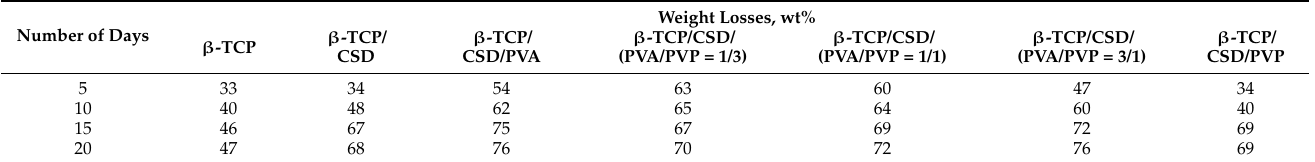
Figure 6. Relative viscosity measurement of the 5% solution of the PVA/PVP mixture. Table 2. Weight losses of the composites and the initial β -TCP depending on the duration of sample soaking in the physiological solution.